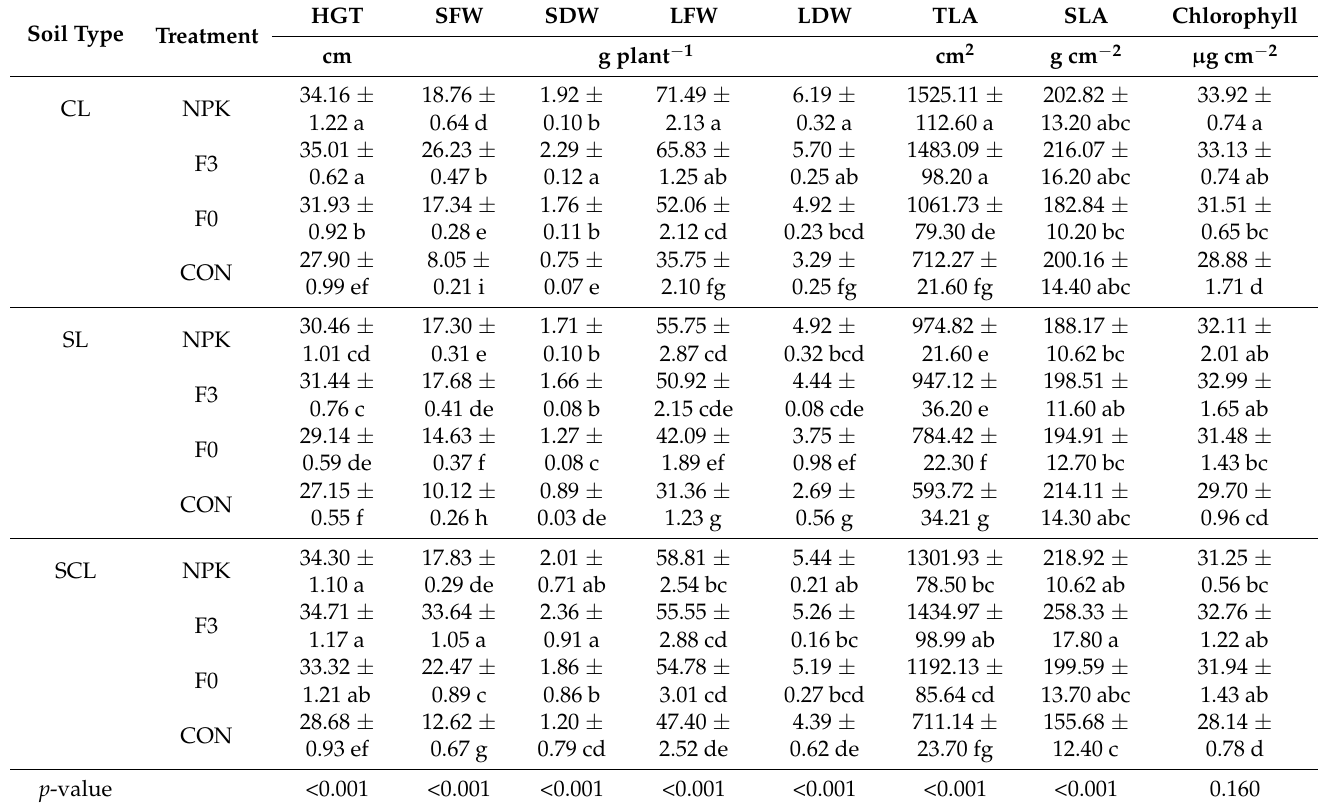
Table 4. Means ( ± SE) of the interaction effect between soil types and treatments on the plant growth